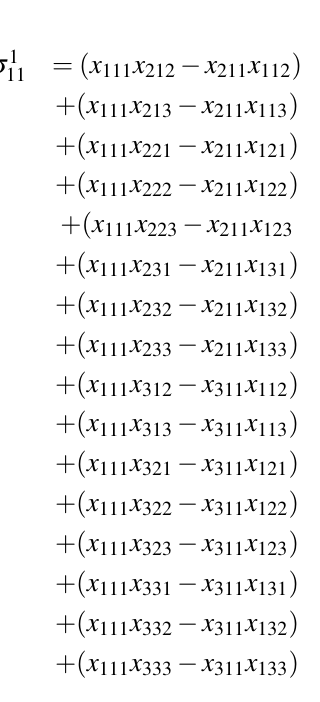
Figure 1: Geometrical Structure of 2 × 2 × 2 Contingency Table